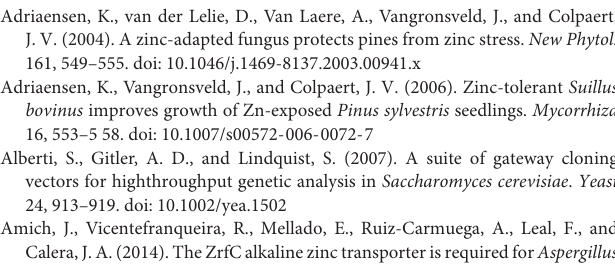
vector (EV, pAG306GAL-ccdB-EGFP; Alberti et al., 2007), the mutant strain (cid:49) zrt1 (cid:49) zrt2 with either the EV or the vector containing SlZRT1:GFP . The experiment was carried out for three independent clones and pictures were taken after 4 days of growth. FIGURE S2 | Fe concentration in transformed yeast cells (A,B) . The WT strain was transformed with the EV (pYES-DEST52, Invitrogen), the mutant strain with either the EV or the vector containing SlZRT1 . Data are the average ± SE of five biological replicates, significant differences ( p < 0.05) are indicated by